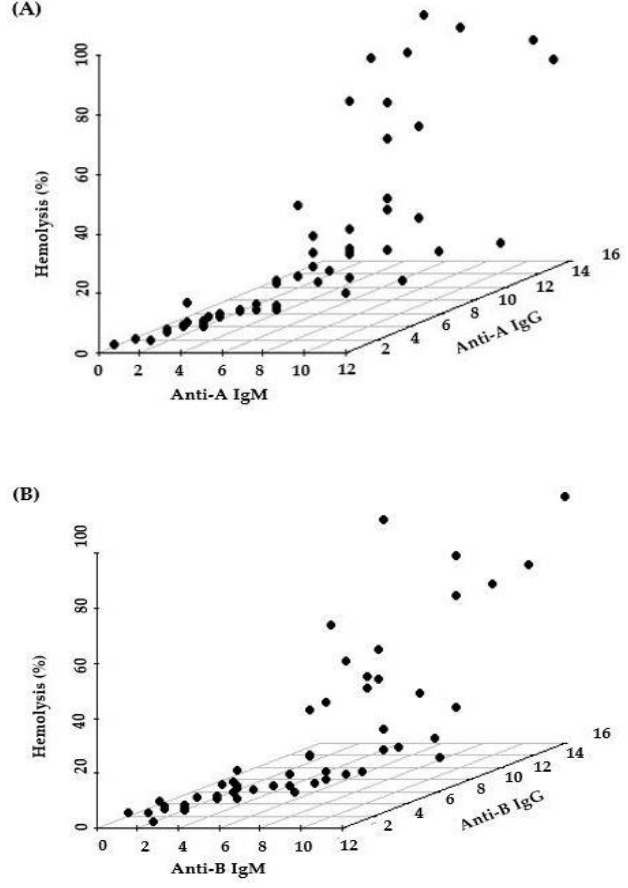
Figure 3. Hemolysis value (%) according to IgM and IgG of Anti-A and Anti-B using 3D scatter- plot. Table 2. Multiple linear regression analysis results of hemolysis (%) related to ABO Ab titers.